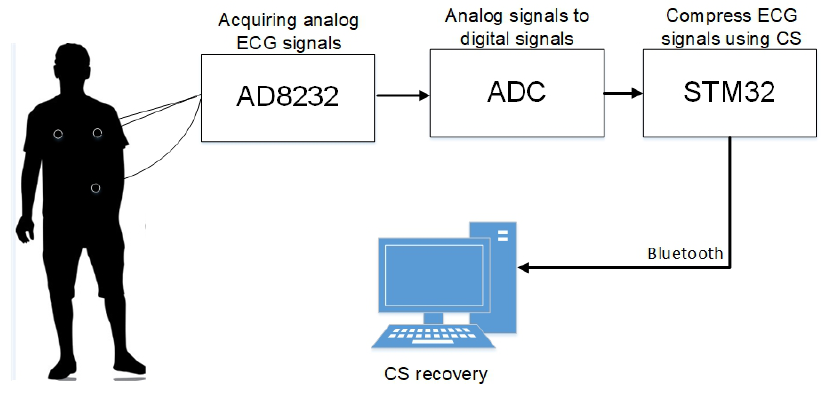
Figure 2. Block diagram of a wearable ECG telemonitoring system.